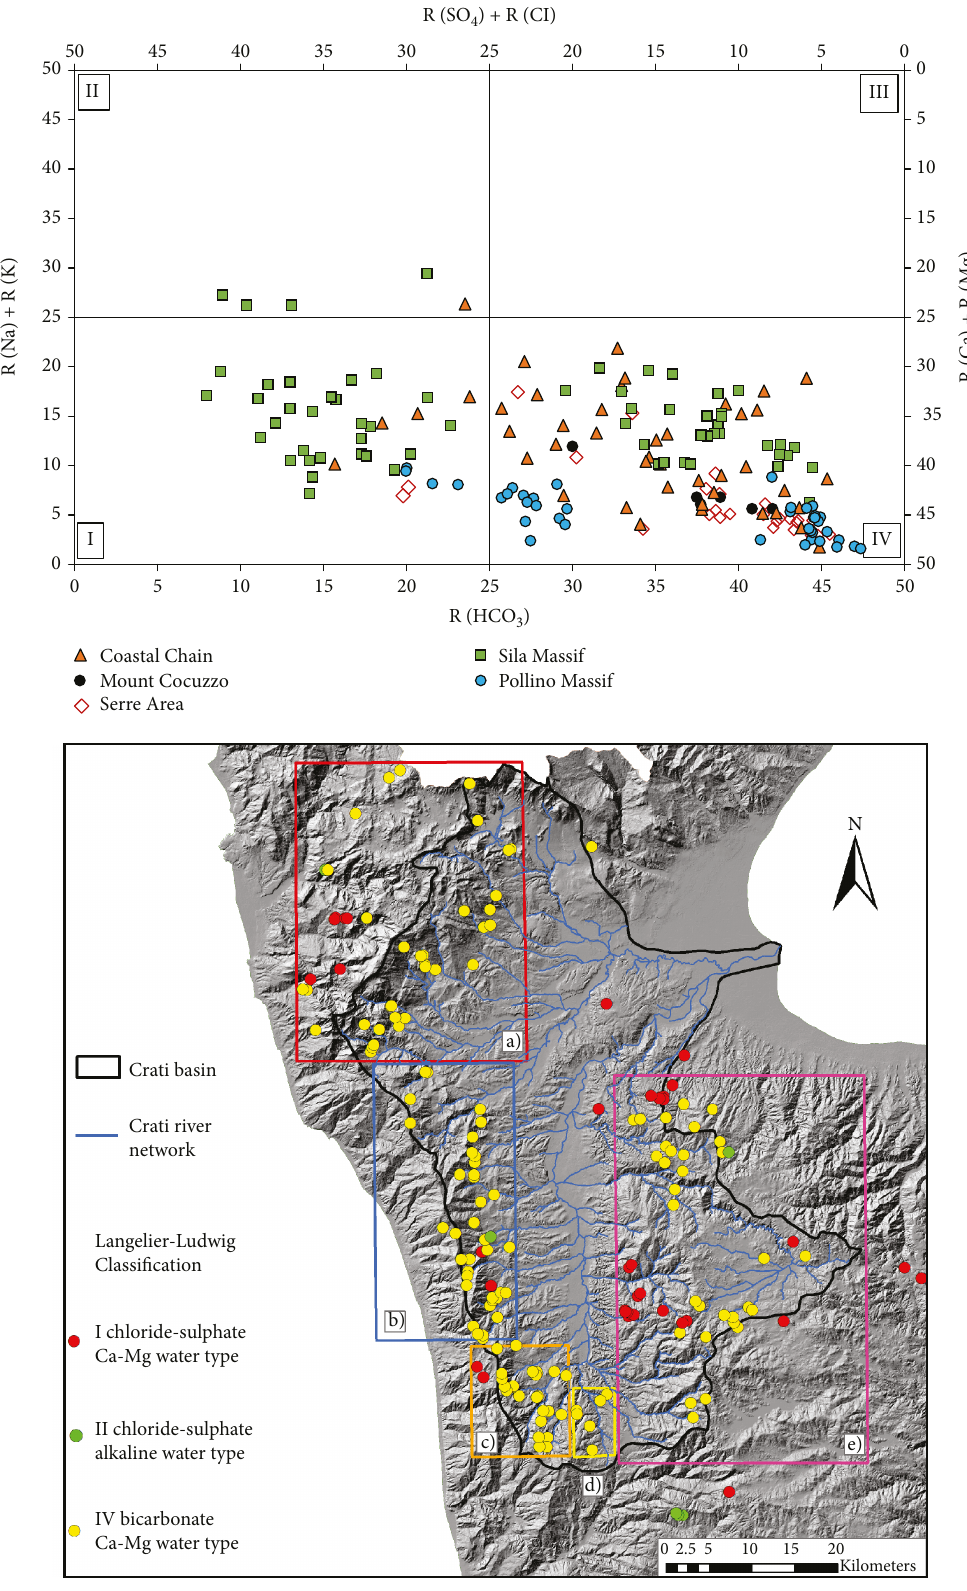
Figure 2: Langelier-Ludwig squared diagram for each area and spatial distribution of the spring water geochemical